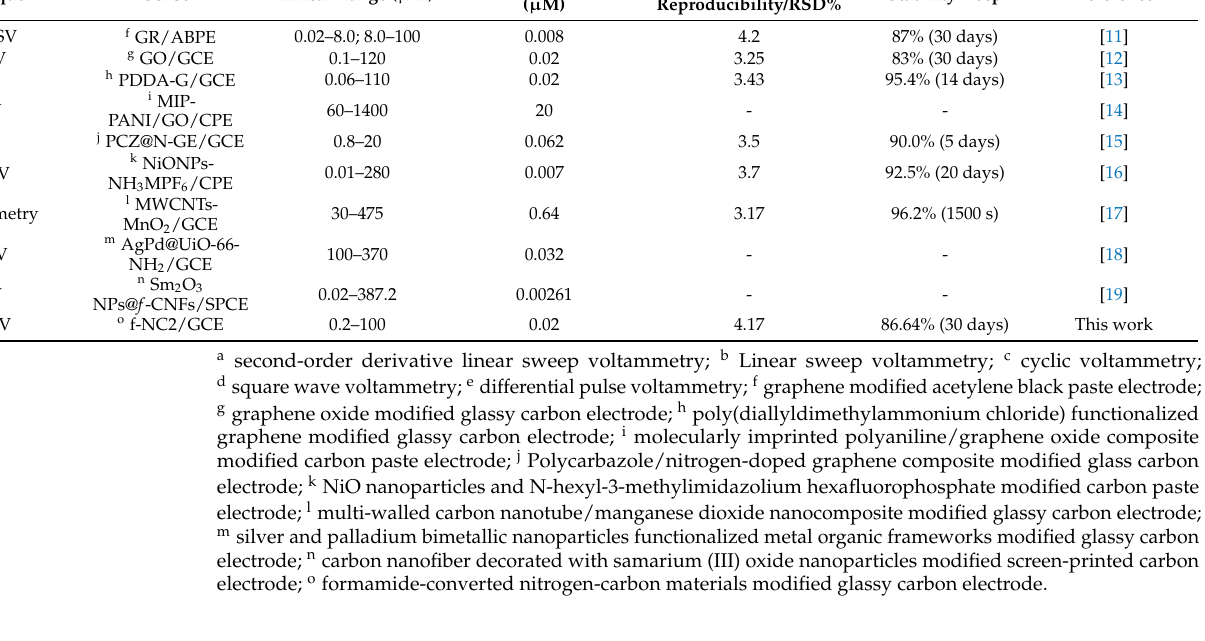
Figure 9. The curves of SDLSV of different concentration 4-NP in 0.2 M H 2 SO 4 solution obtained at the f-NC2/GCE at a scan rate of 0.1 V s −1 after accumulation at 0.3 V for 60 s. ( A ) a–i: 0.2, 0.4, 0.6, 0.8, 1.0, 2.0, 4.0, 6.0, 8.0 µ M; ( B ) a–f: 10, 20, 40, 60, 80, 100 µ M. ( C ) The linear relationship between the I p and 4-NP concentration in range of 0.2 to 100 µ M. ( D ) Calibration curve for 4-NP in low concentration range (0.2–8.0 µ M). Table 1. Performancecomparisonofthef-NC2/GCEwithotherelectrochemicalsensorsfor4-NPdetection.